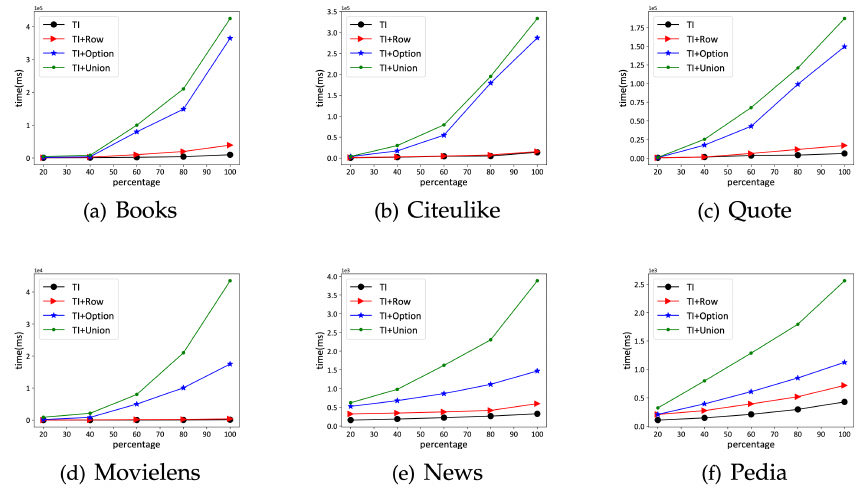
Figure 4. Evaluation of index-construction time.